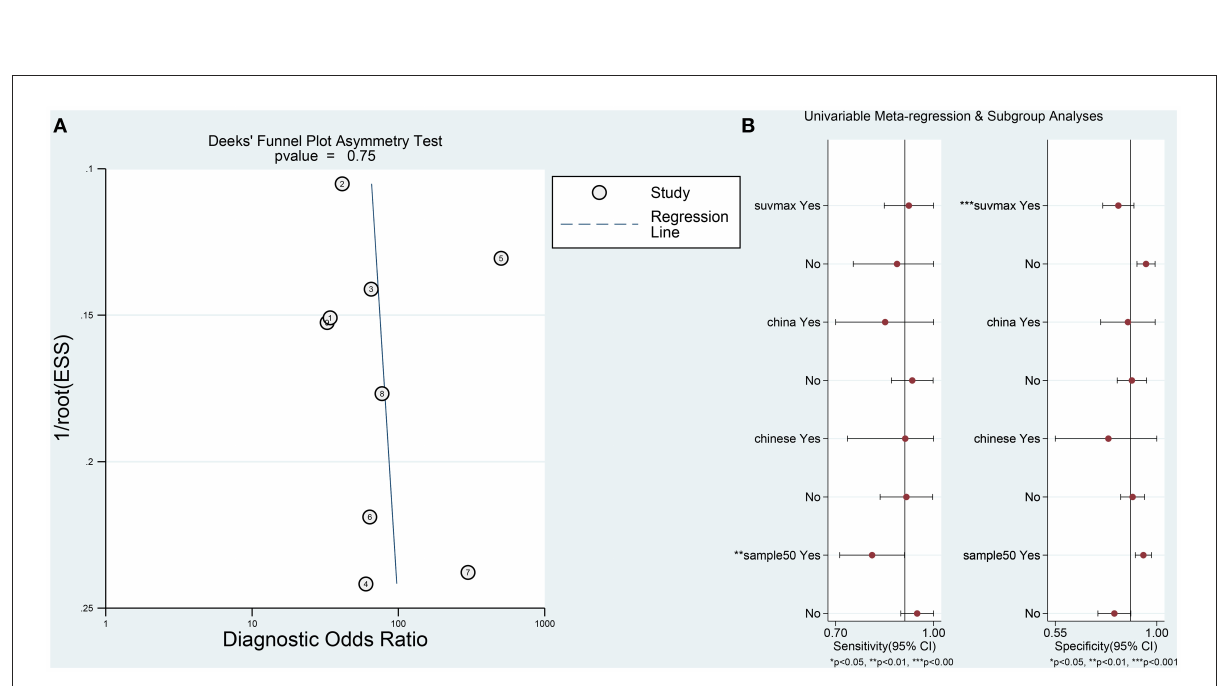
FIGURE5 (A) The results of Deeks’ funnel plot asymmetry test to assess publication bias. (B) Univariable meta-regression analysis for sensitivity and specificity of the 18F-FDG-PET/CT diagnosis of PCNSL and